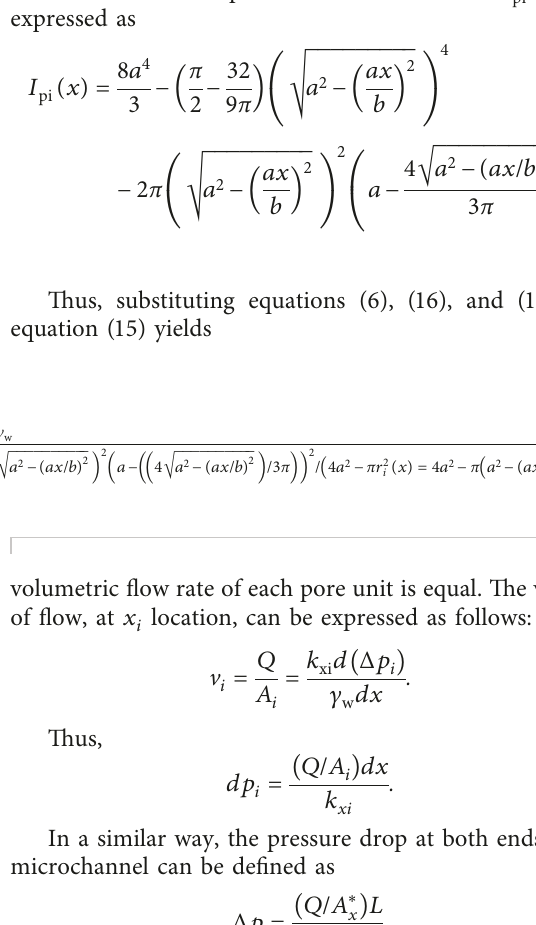
Figure 5: Relationship between particle size and critical velocity in laminar flow. The paper selects six groups with different values of major half-axis b , analyzing the changes between critical velocity and major half-axis a